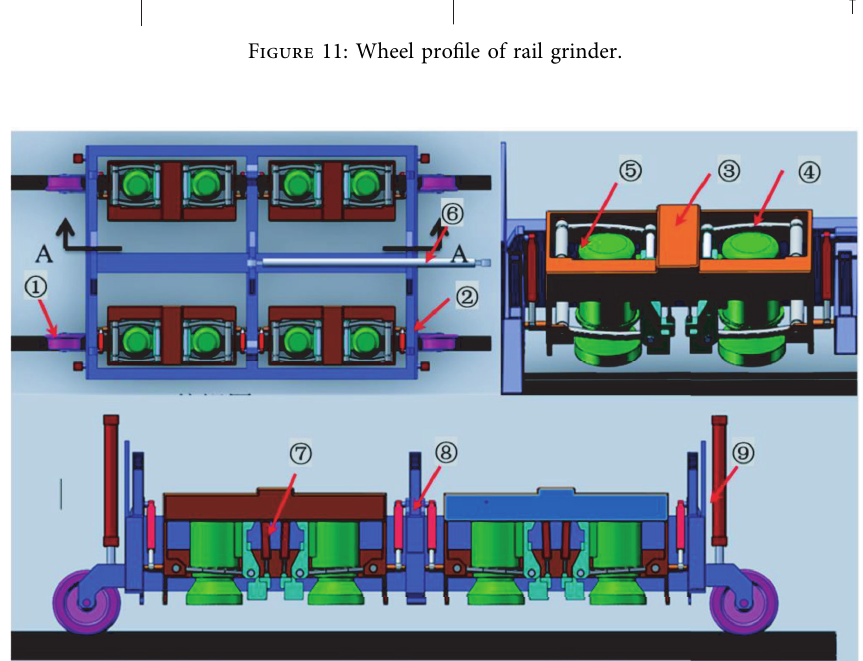
Figure 12: Multibody model of rail grinder(1) Rail grinder wheel. (2) Rail grinder bogie. (3) Grinder carriage. (4) Grinder motor hoisting mechanism. (5) Grinder motor. (6) Traction rod. (7) Hoisting pneumatic cylinder of grinder motor. (8) Grinder-carriage deflection cylinder. (9) Rail grinder bogie lifting